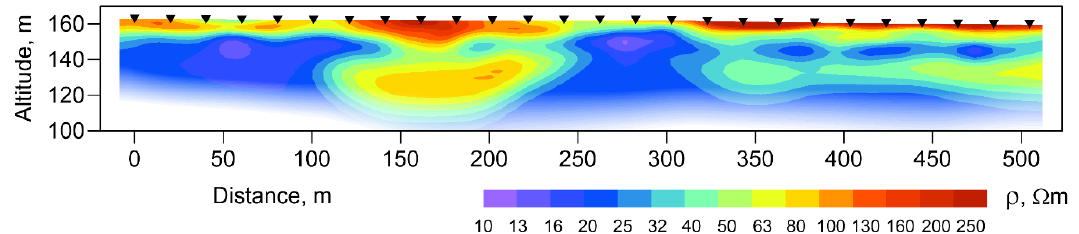
Figure 9. An example of resistivity cross-sections employed to create the shallow part of Aleksandrovka conductivity model. The cross-sections were obtained previously as a result of the 2D inversion of a CSRMT survey.